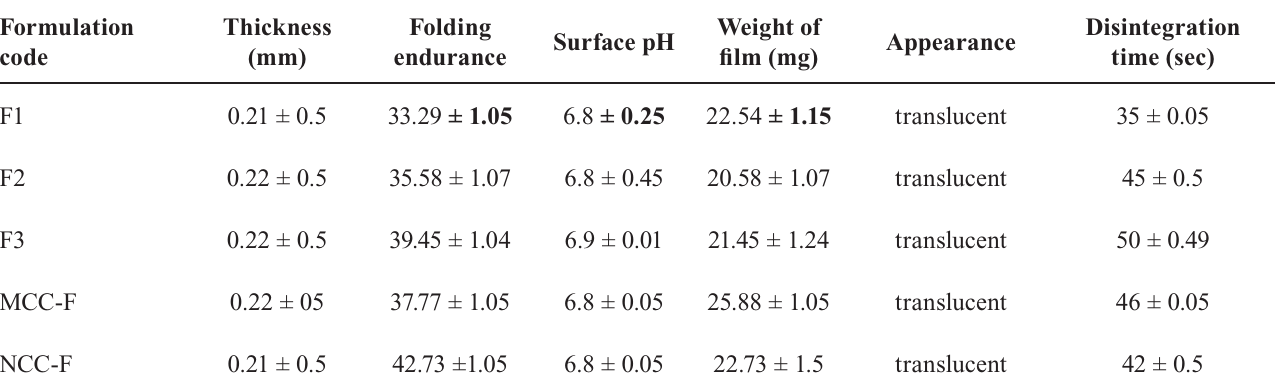
TABLE II - Physical evaluation parameters of ODF formulation